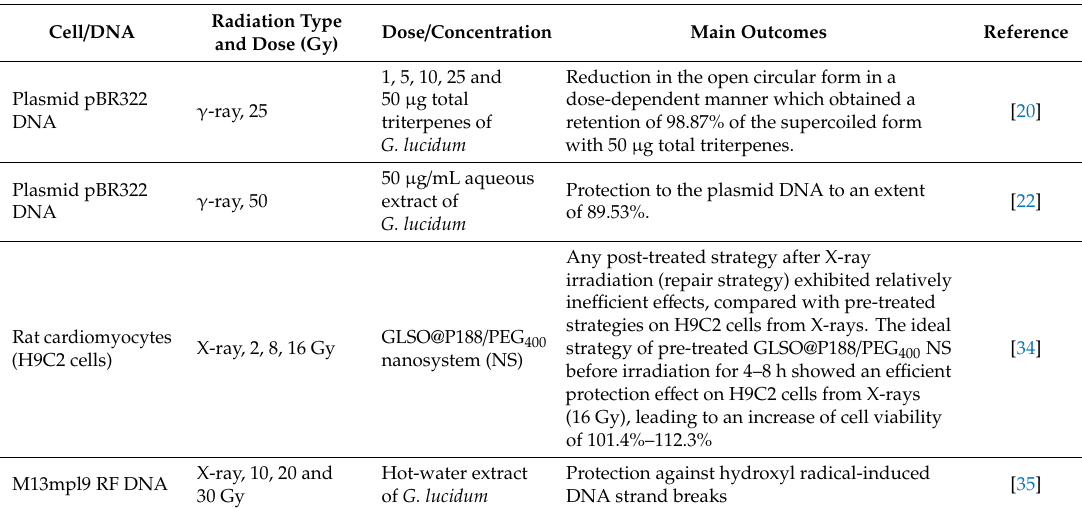
Table 4. Summary of articles focused in vitro radioprotective e ff ect of Ganoderma lucidum included in the systematic